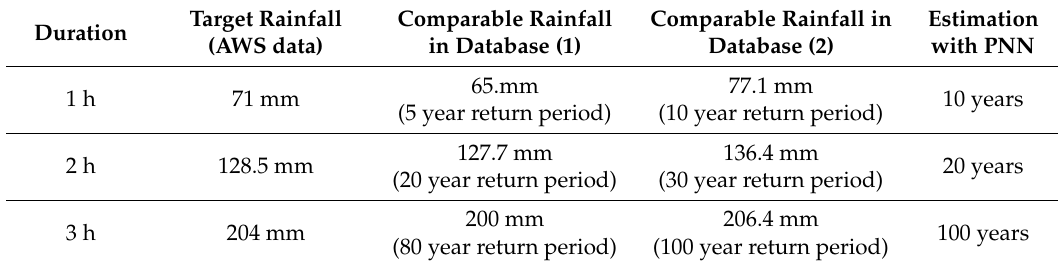
Table 4. Results of Return Period Estimation using a Probabilistic Neural Network